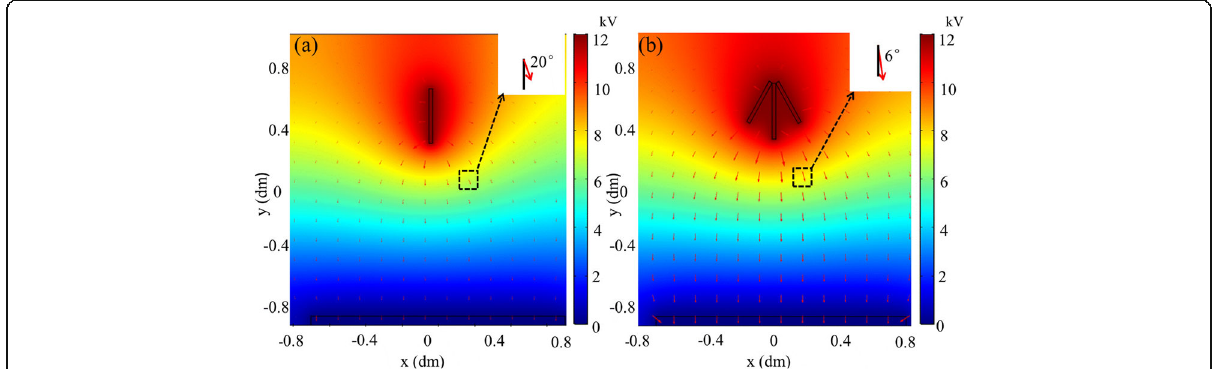
Fig. 3 Electric field distribution of e-spinning models equipped a without and b with a metal cone. Insets are enlarged images of the same area and show the angle between the field line and the vertical